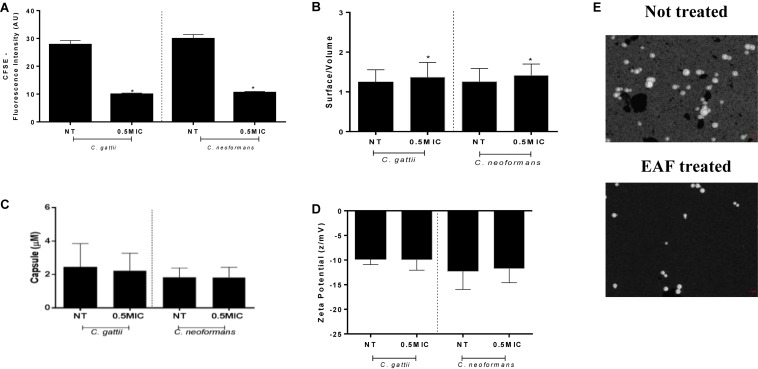
Ethyl acetate fraction stress impairs the cell membrane and increases the surface/volume ratio with no changes on the cell net charge. Cells exposed to 0.5 × MIC of EAF for 24 h were less labeled than the non-treated cells for both species. Data are represented in arbitrary units of fluorescence (AU) (A). Morphometric data are obtained by India ink and are represented by a ratio of surface/volume for cell size (B) and micromolars for capsule (C). Zeta potential data are expressed in z/mV (D). Stained cells (E). Data of experiments are represented as the mean ± SEM of two independent experiments in triplicate assays. An asterisk represents statistical differences between the treatments and the control (p < 0.05). EAF, Ethyl acetate fraction; NT, No treatment; MIC, Minimal inhibitory concentration; CFSE, Carboxyfluorescein succinimidyl ester.